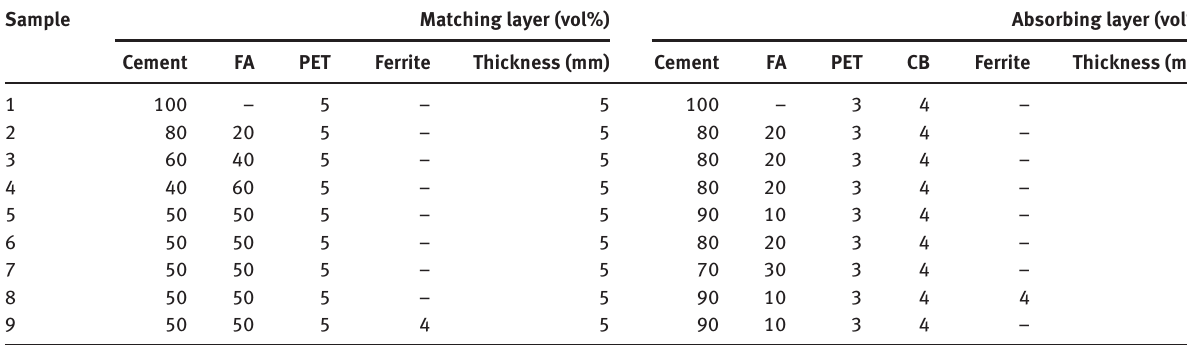
Table 2: The mixed proportion of double-layer cement composites.